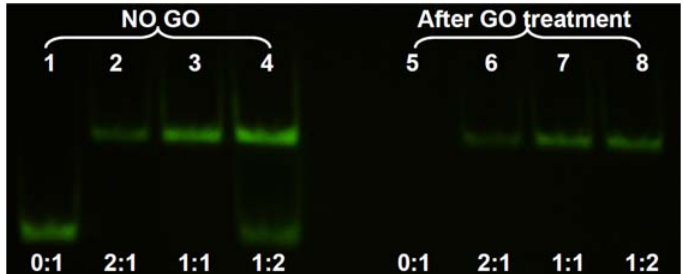
Figure 3. Non-denaturing polyacrylamide gel electrophoresis of the supernatant solution after DNA adsorption by GO and centrifugation. The lower bands are the ss-DNA and the upper bands are the ds-DNA. After GO treatment, only ds-DNA was left in the